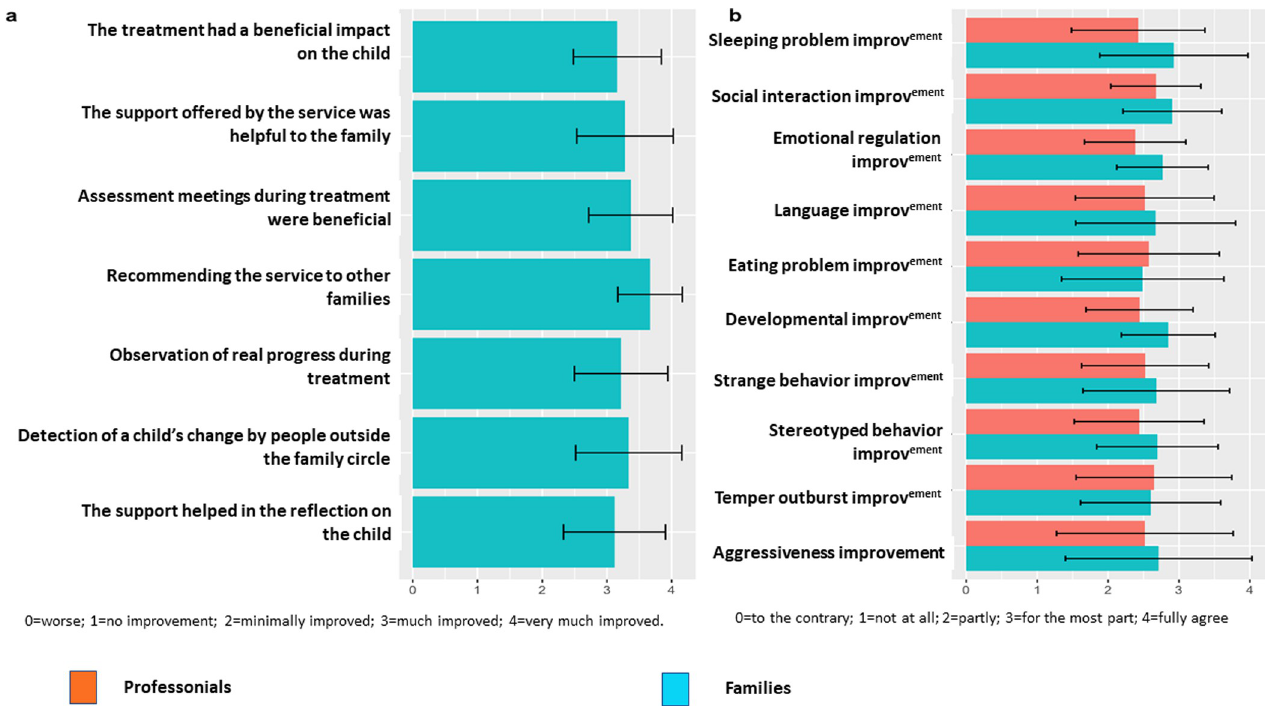
Fig 3. Families’ subjective views of their children’s improvement (3a) and of the services provided (3b).